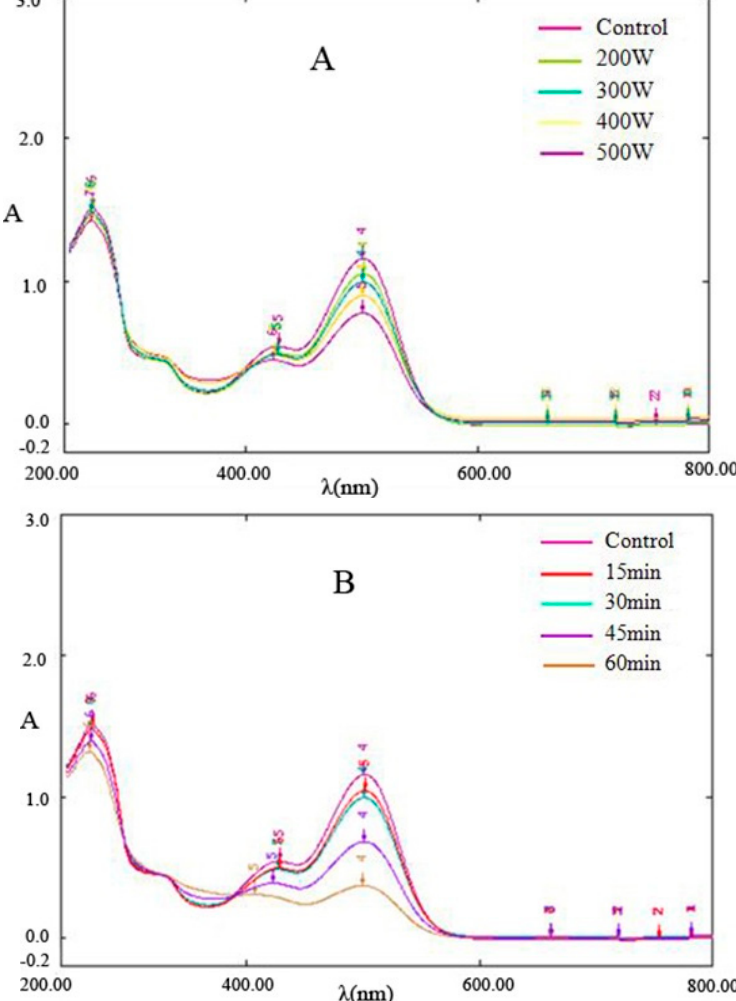
Figure 2. Effect of ultrasonic power and time on the spectral characteristics of Cy-3-glu ( n = 3). Note: ( A ) 30 min processing; ( B ) 300 watt power.